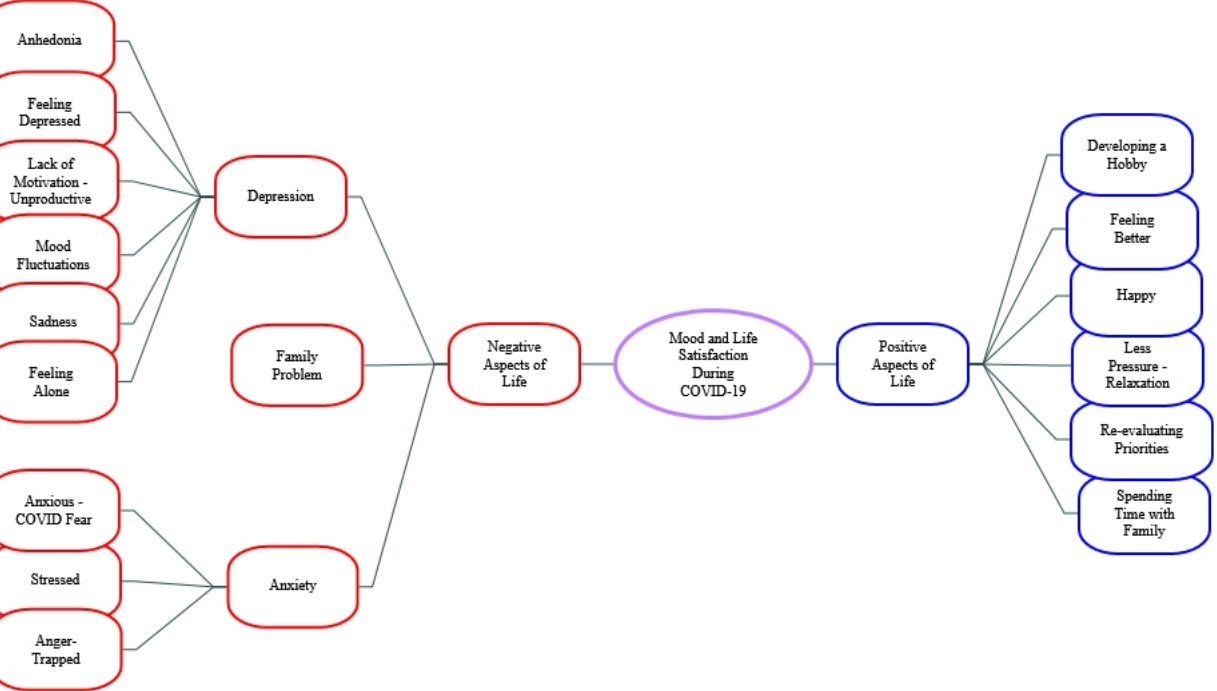
Figure 6. Themes and Sub–themes regarding mood and life satisfaction during COVID-19 . Across all participants, negative aspects of mood and life satisfaction during COVID- 19 fell into 3 sub–themes: Depression, Anxiety and Family problems. Depression was the